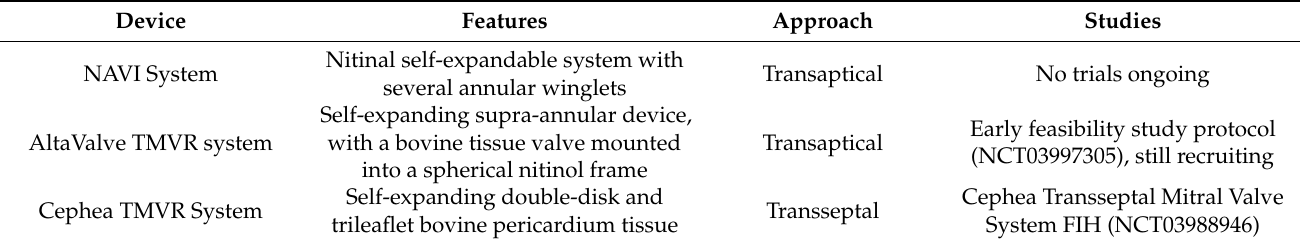
Table 5. Features, and Studies of new TMVR Devices